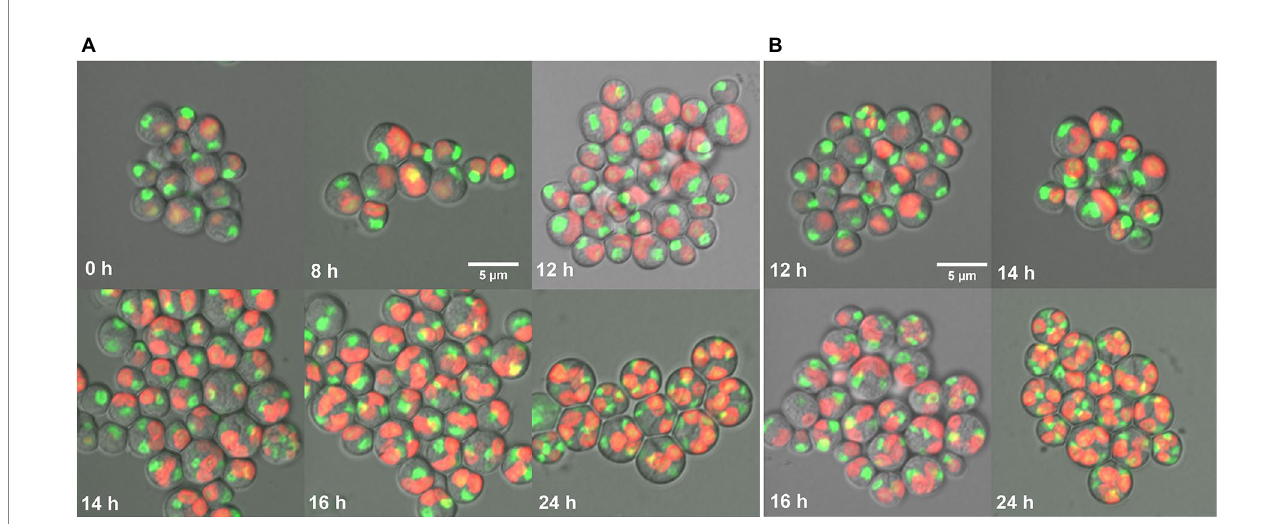
FIGURE 5 Fluorescent photomicrographs of cells of Galdieria sulphuraria under control conditions (A) , and in a CFL–treated culture (B) . Control culture: daughter cells - 0 h, growing single cells - 8 h, 1 st division of chloroplast and nuclei - 12 h, division into 2 cells - 14 h, division into 4 cells, protoplast division apparent - 16 h, four daughter cells growing inside the original mother cell wall before their release - 24 h. CFL–treated culture: chloroplast and nuclei started to divide - 12 h, apparent division into 2 cells - 14 h, started division into 4 cells and protoplast fission apparent - 16 h, four daughter cells growing inside the original mother cell wall before their release - 24 h. Nuclei in green were stained by SYBR Green I, chloroplasts in red - autofluorescence of chlorophyll. The bar represents 5 μ m.